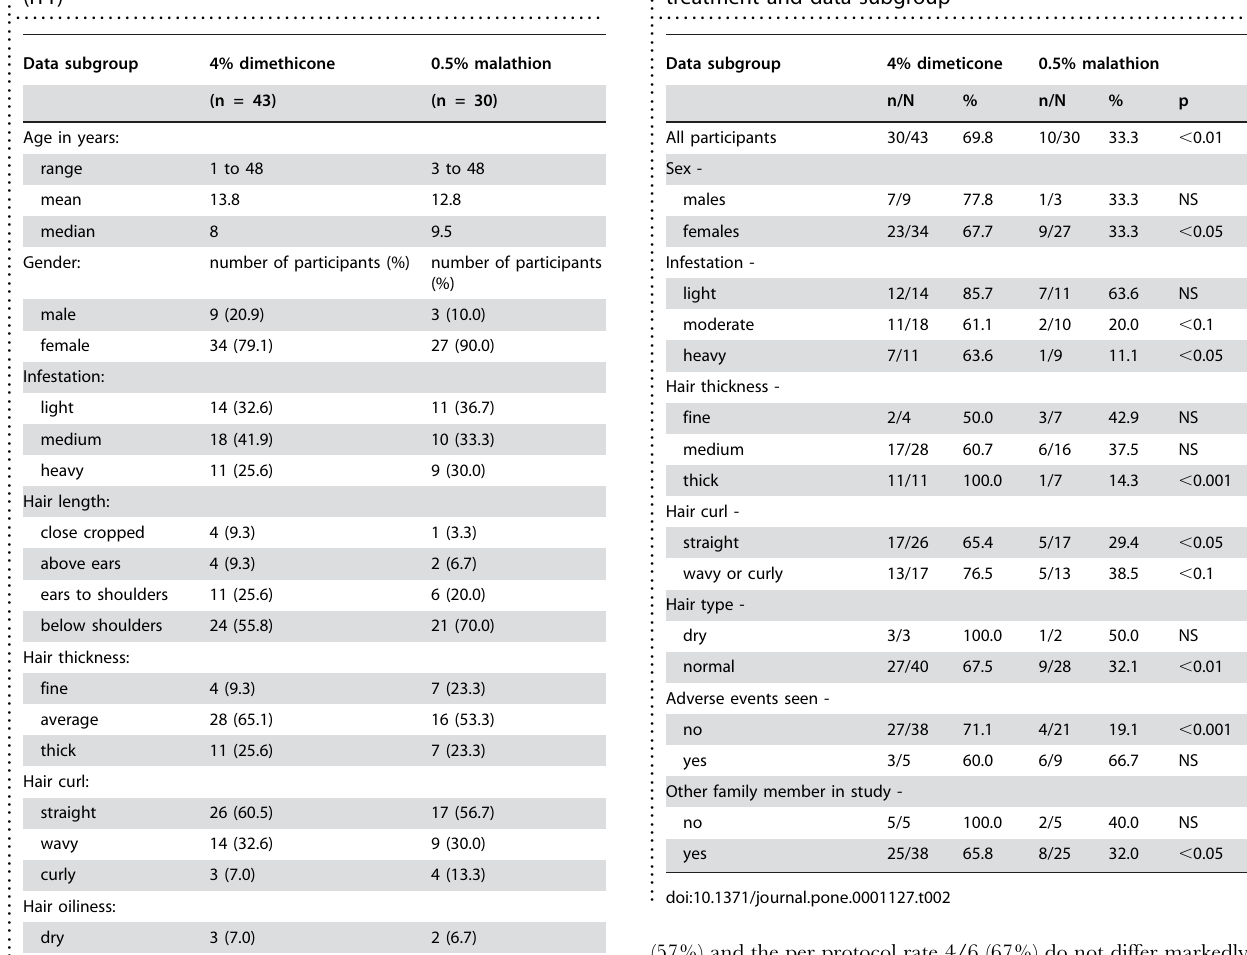
Table 2. Comparison of rates of positive outcome by Table 1. Baseline demographic characteristics of